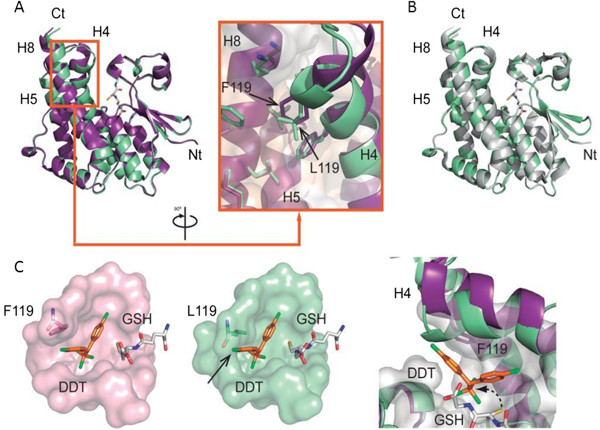
GSTe2 three-dimensional structure variations reveal that L119F is important for DDT resistance. (A) Overlay of Benin-GSTe2 (purple) and Uganda-GSTe2 (green) structures and a close-up of the H4/H8 helices containing the L119F mutation. (B) Overlay of Uganda-GSTe2 (green) and An. gambiae GSTe2 (grey) structures showing their very similar conformation. (C) Comparison of the substrate-binding pockets of Benin-GSTe2 (purple) and Uganda-GSTe2 (green). (Left) The molecular surface representation of the H-site shows that DDT docks well into the Benin-GSTe2 binding site but clashes with the Uganda-GSTe2 structure. (Right) Close-up of the effect of L119F on the H-site (this mutation bends H4, leading to an increase in the DDT-binding cavity in Benin-GSTe2 but not for Uganda-GSTe2). Ct, C-terminal; DDT, dichlorodiphenyltrichloroethane; GSH, glutathione; Nt, N-terminal.